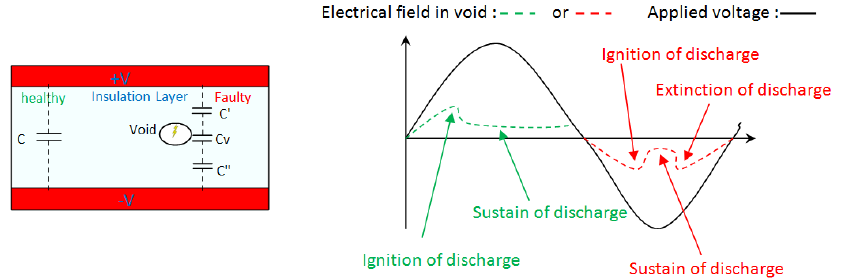
Figure 25 . One case of partial discharge. One bubble is present in the insulation wall and modifies its behavior. The new capacitor (Cv) has a lower breakdown voltage. When applied voltage induces a too high electrical field in the bubble, discharges occur and avalanche current increase the insulation leakage current.